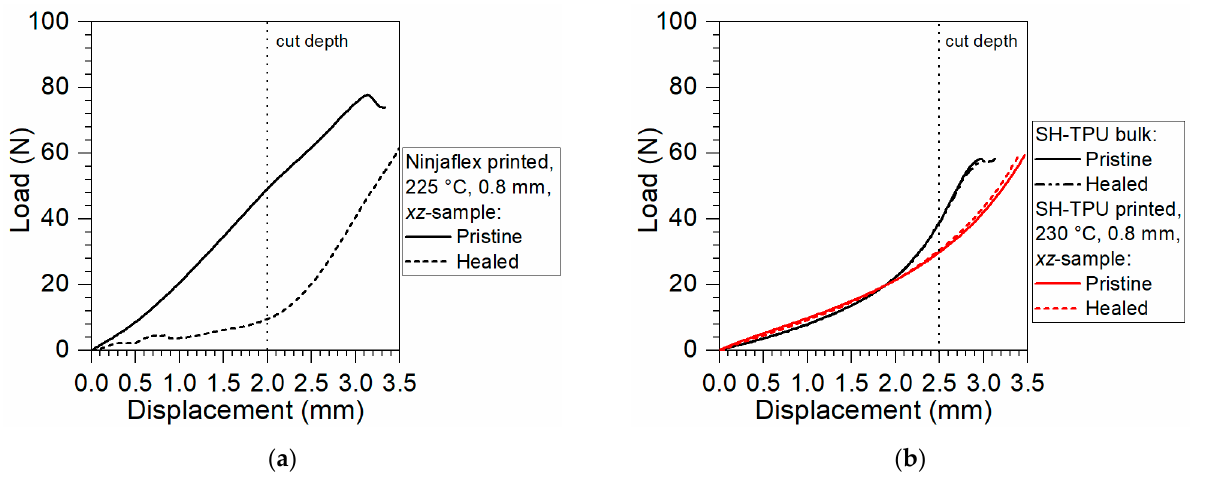
Figure 13. Compression-cut mechanical characterisation of the healed ( a ) Ninjaflex and ( b ) SH-TPU polymers healed at 30 °C/24 h and tested at 20 °C, 10 mm/s. Vertical dotted lines indicate the position of the cut created during the first compression-cut test that was subsequently healed.